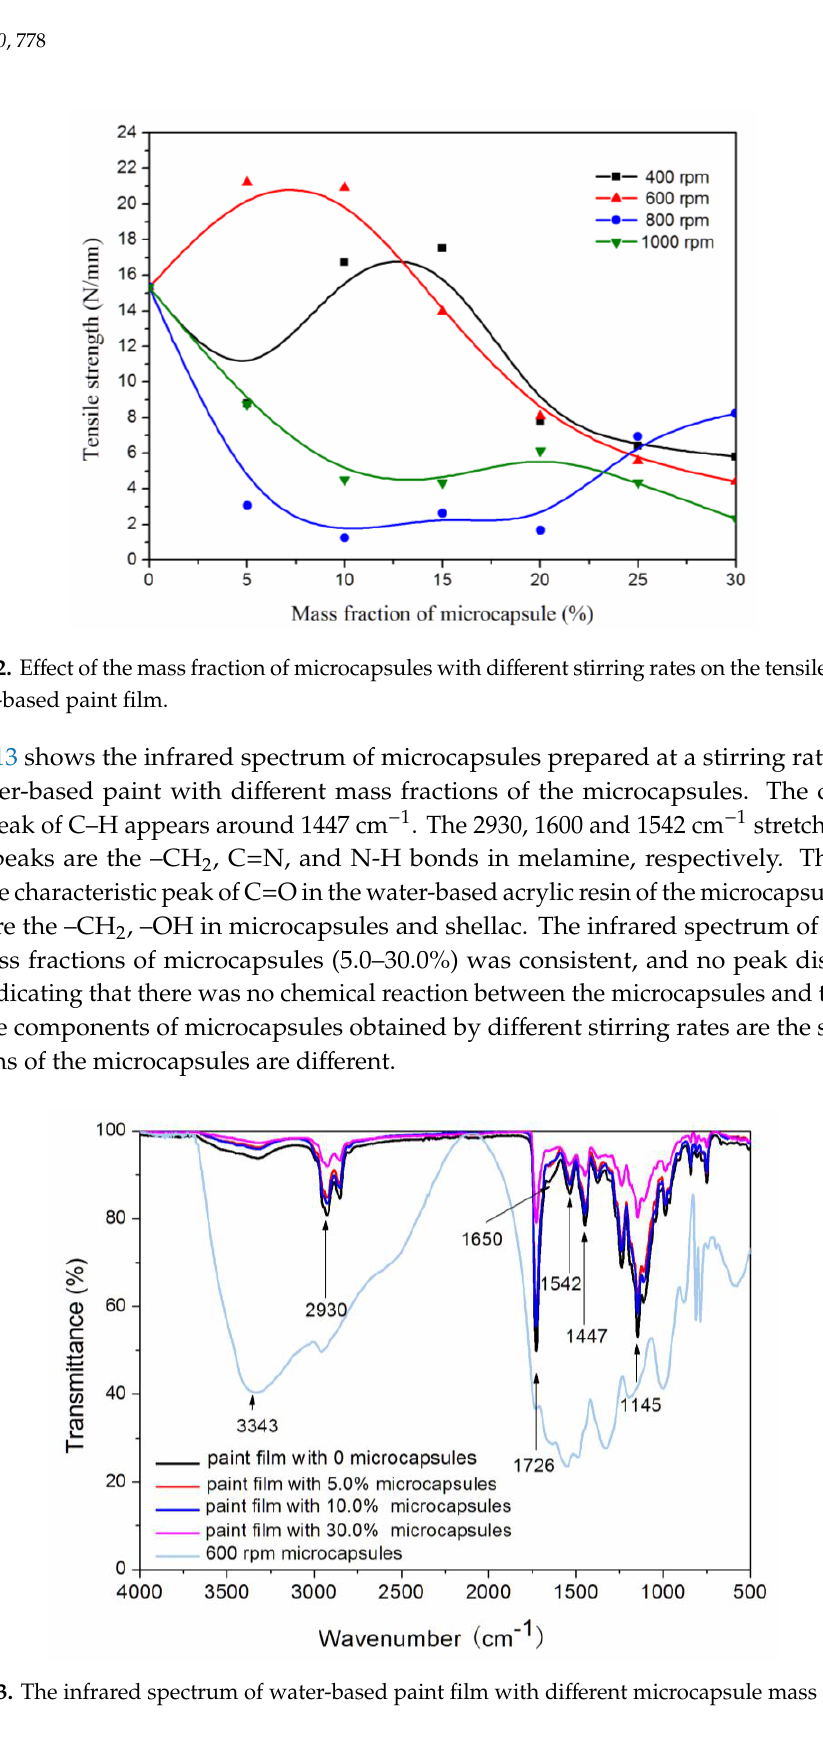
Figure 14. Effect of different microcapsule mass fractions on the repair effect of the paint film: ( A ) and ( B ) are the paint film before and after repairing with the microcapsule mass fraction of 5.0%; ( C ) and ( D ) are the paint film before and after repairing with microcapsule mass fraction of 10.0%.